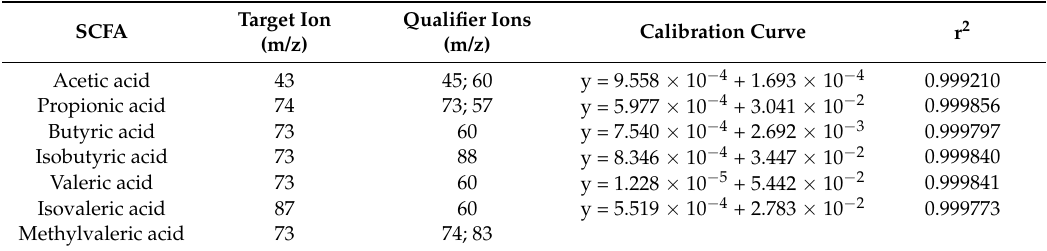
Table 2. Mass of target ion and qualifier ions used to identify short-chain fatty acids (SCFAs) and calibration curve data for the